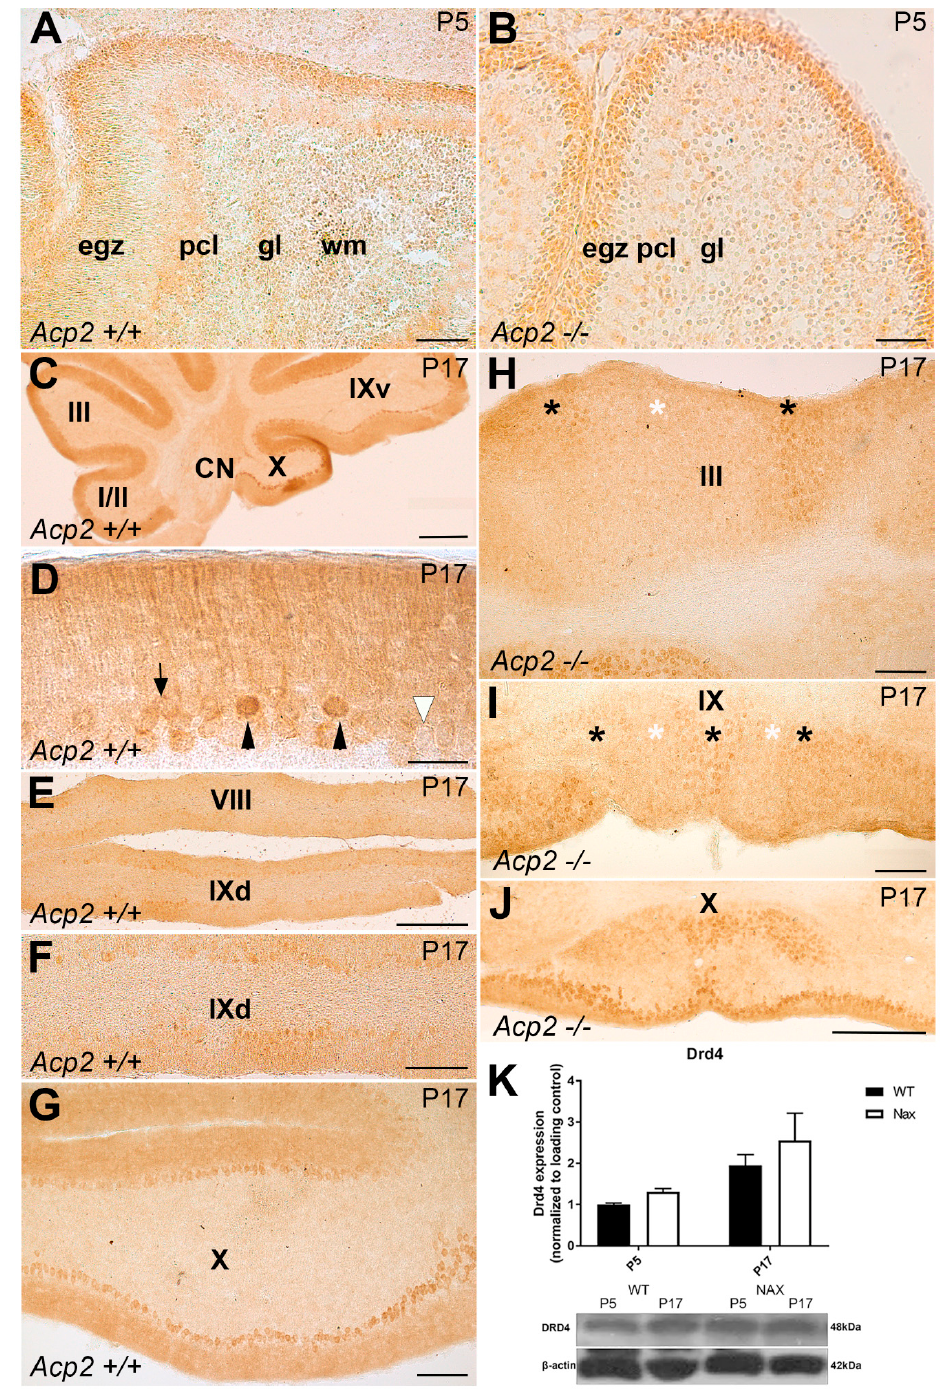
Figure 5. Frontal and sagittal sections of wt and nax mouse cerebella: DRD4 expression at P5 and P17. ( A , B ) Immunoperoxidase staining for DRD4 in wt ( A ) and nax ( B ) cerebella at P5 shows immunoreactivity in the external germinal zone (egz) and no or only weak immunoreactivity in the